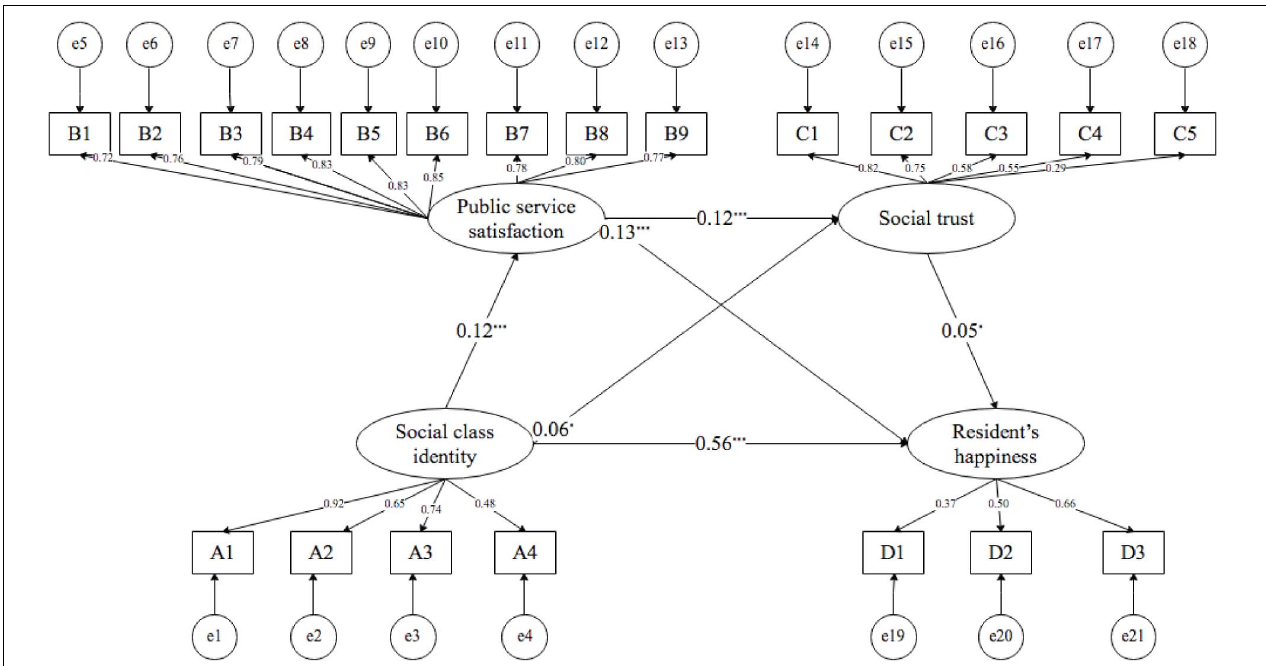
FIGURE 2 | Structural equation modeling results. * P < 0.05, ** P < 0.01, *** P <